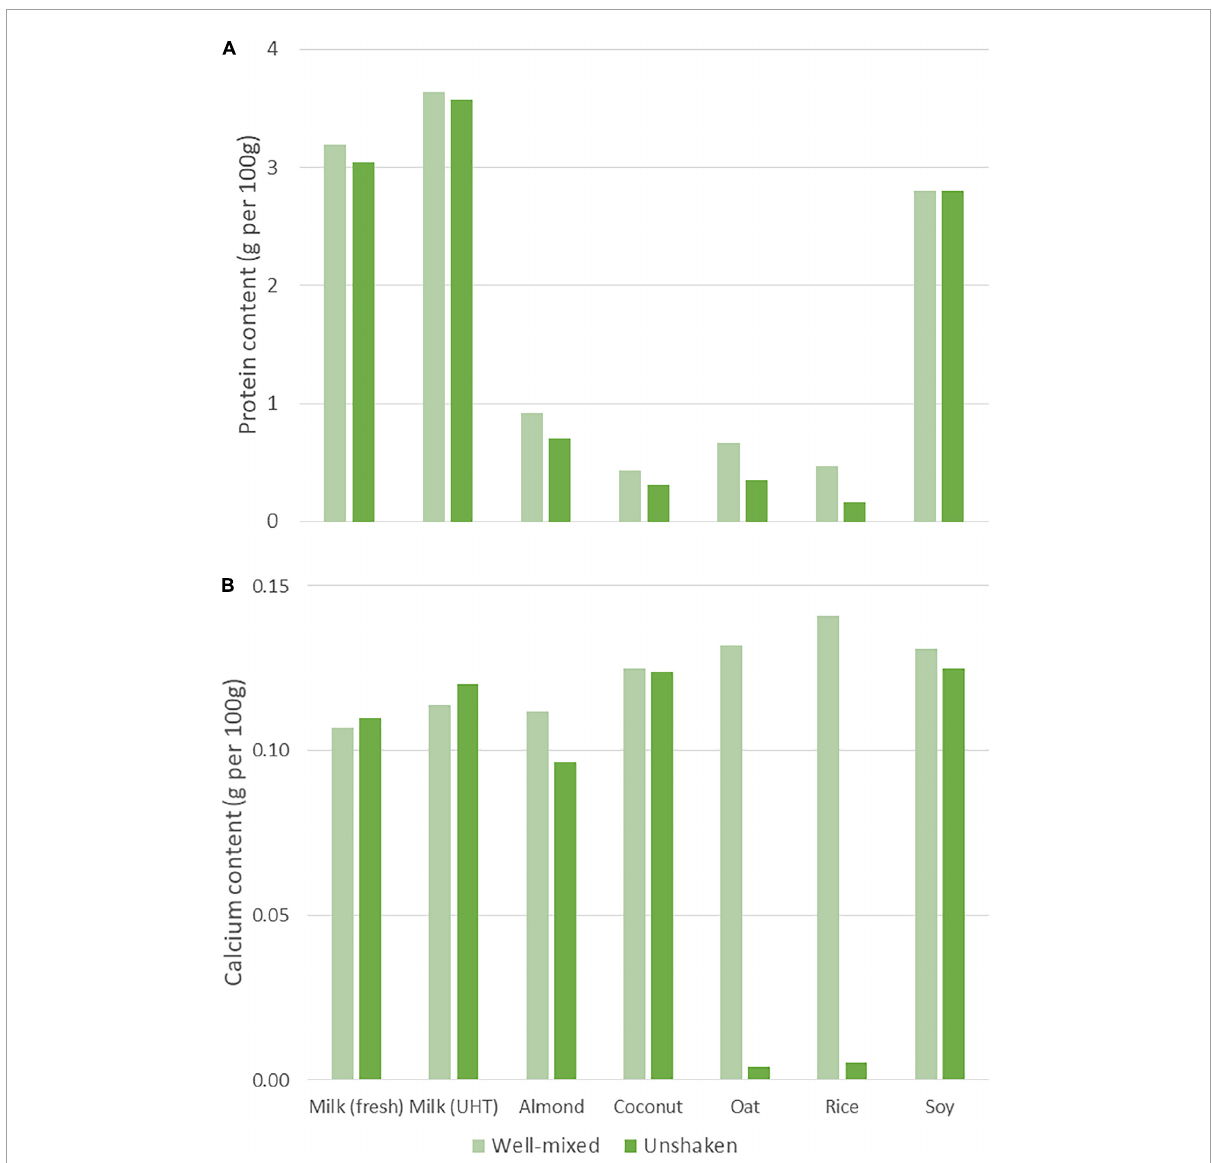
FIGURE3 Comparison between the protein (A) and calcium (B) content of well-mixed samples and unshaken samples. A single representative product was analyzed for each product